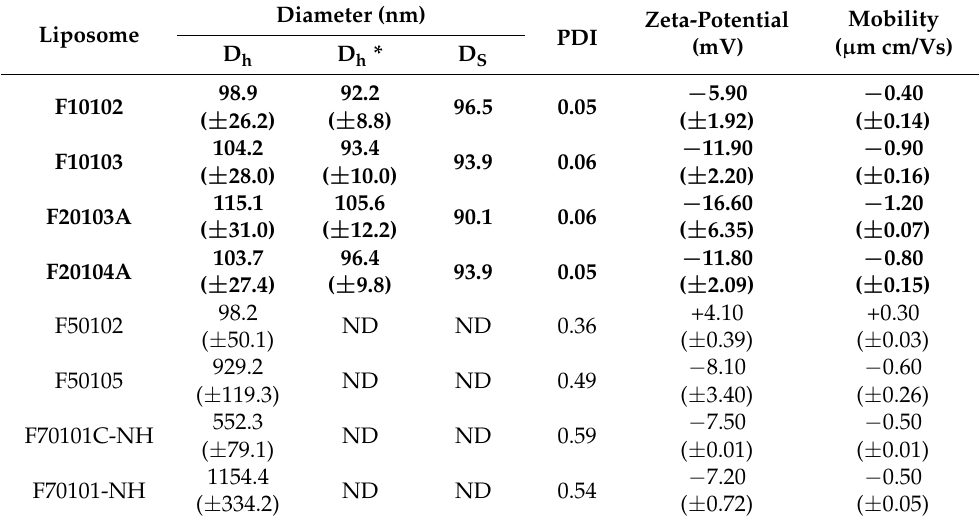
Table 2. Hydrodynamic diameter was measured by batch-mode DLS (intensity-based mean of the most prominent peak) (D h ) and in flow mode by AF4-DLS (Z-average at peak maximum) (D h *). The Stokes diameter (D S ) was measured by analytical ultracentrifugation. Zeta-potential and mobility were also determined by ELS. Values are reported as an average of three measurements. SD is reported in brackets. ND: not determined. Monodisperse liposomes in the nano-size range are highlighted in bold. Diameter Liposome